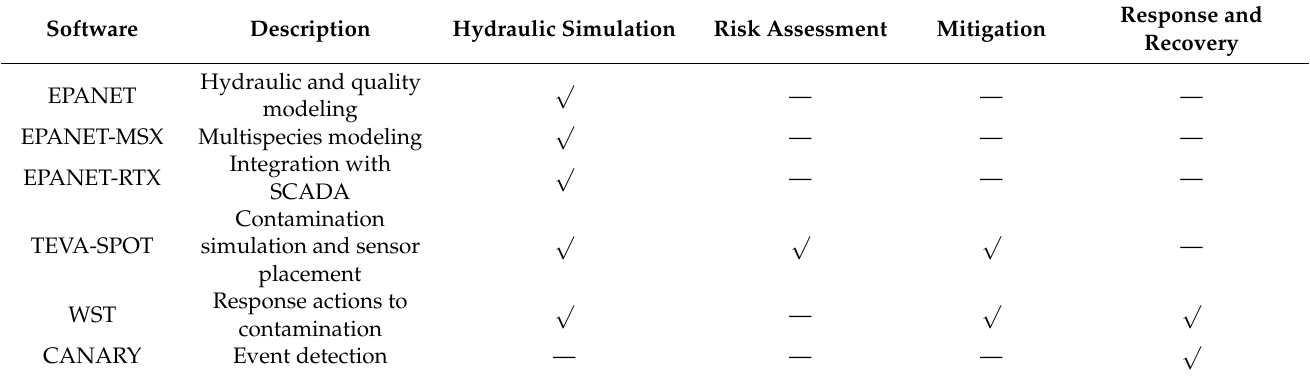
Table 1. Modeling tools for